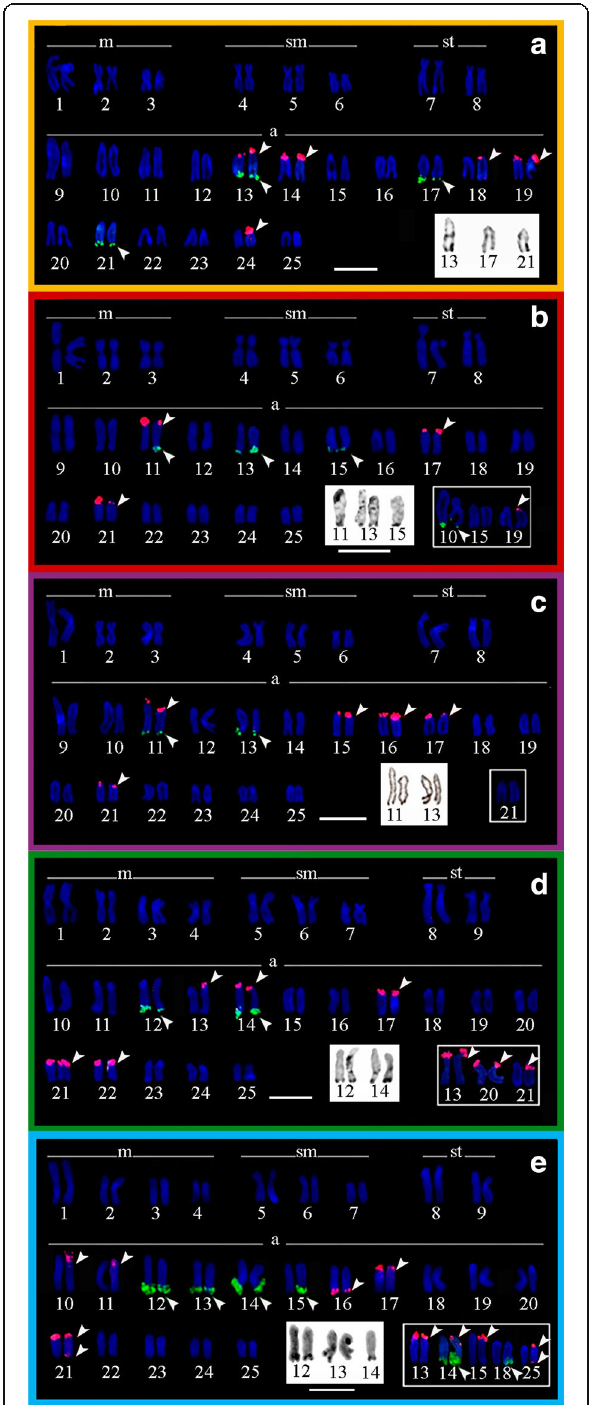
Fig. 2 Karyotypes of Cheirodon species occurring in Chile, arranged from chromosomes after double FISH with 18S (Greenred) and 5S (green) probes (Red). ( a ) Ch. interruptus , ( b ) Ch. pisciculus , ( c ) Ch. galusdae , ( d ) Ch. kiliani , and ( e ) Ch. australe . Chromosomes after silver staining (white box) and chromosome pairs of other individuals of the same species with FISH rDNA probes (black box). Bar equal 10 μ m